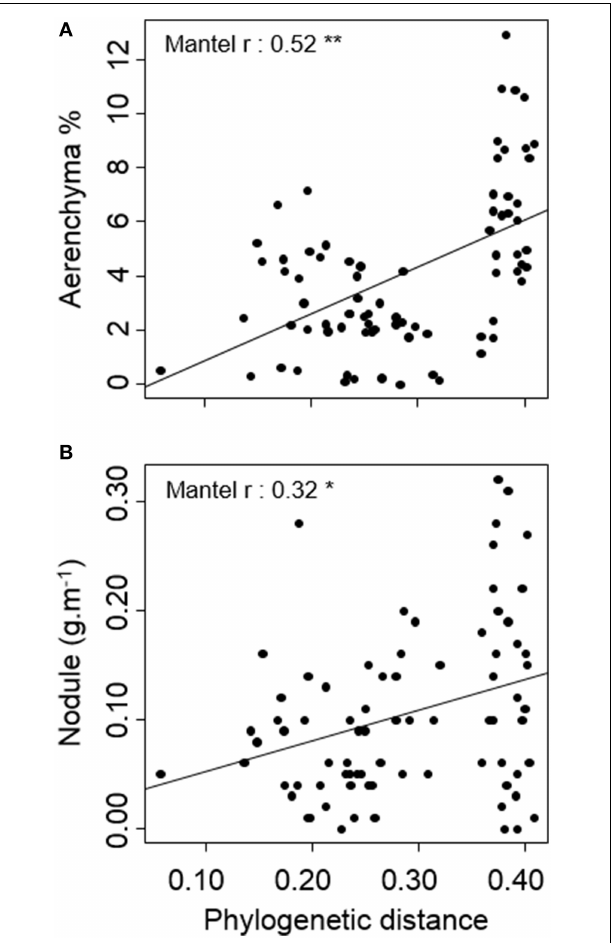
FIGURE 3 | Relation between phylogenetic distance and pair-wise species’ (A) aerenchyma (% of root cross-sectional area occupied by aerenchyma) and (B) nodule (nodule biomass per root length) absolute distances. Lines represent linear regressions between pair-wise species traits and phylogenetic distance. ∗ p < 0 . 05, ∗∗ p < 0 .